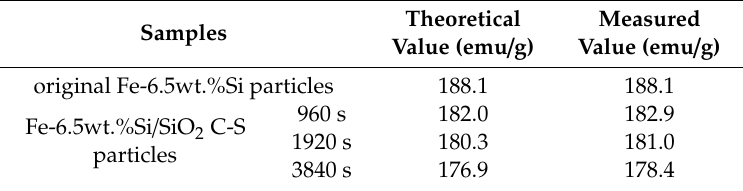
Figure 6. Hysteresis loops and details about the applied magnetic fields and saturated magnetization of the original Fe-6.5wt.%Si particles and Fe-6.5wt.%Si / SiO 2 C-S particles after deposition over various intervals. Table 3. Theoretical and measured saturated magnetization values of the original Fe-6.5wt.%Si particles and Fe-6.5wt.%Si / SiO 2 C-S particles following